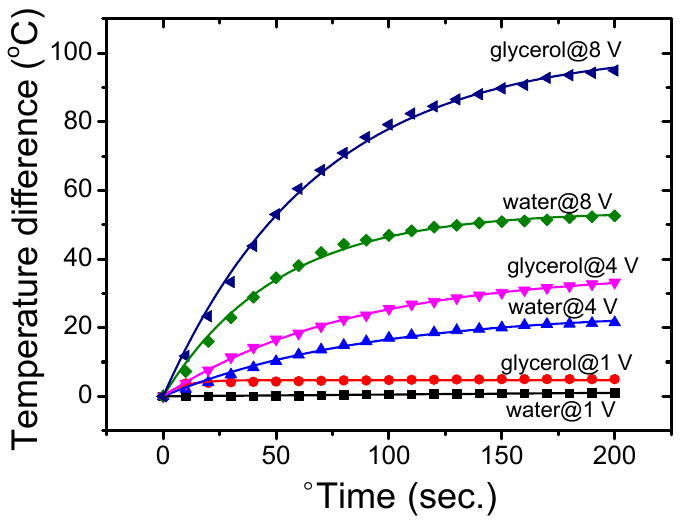
Figure 2. The time courses for temperature difference as a function of heating time using applied voltages of 1 V, 4 V, and 8 V for water and